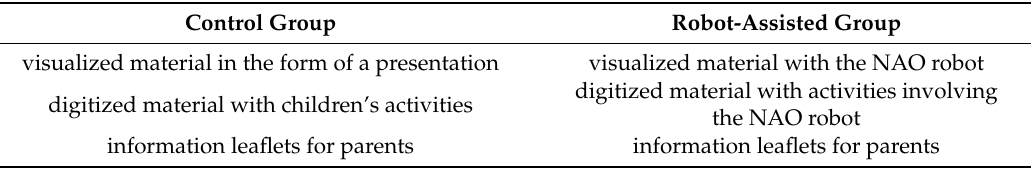
Table 1. List of materials for the two